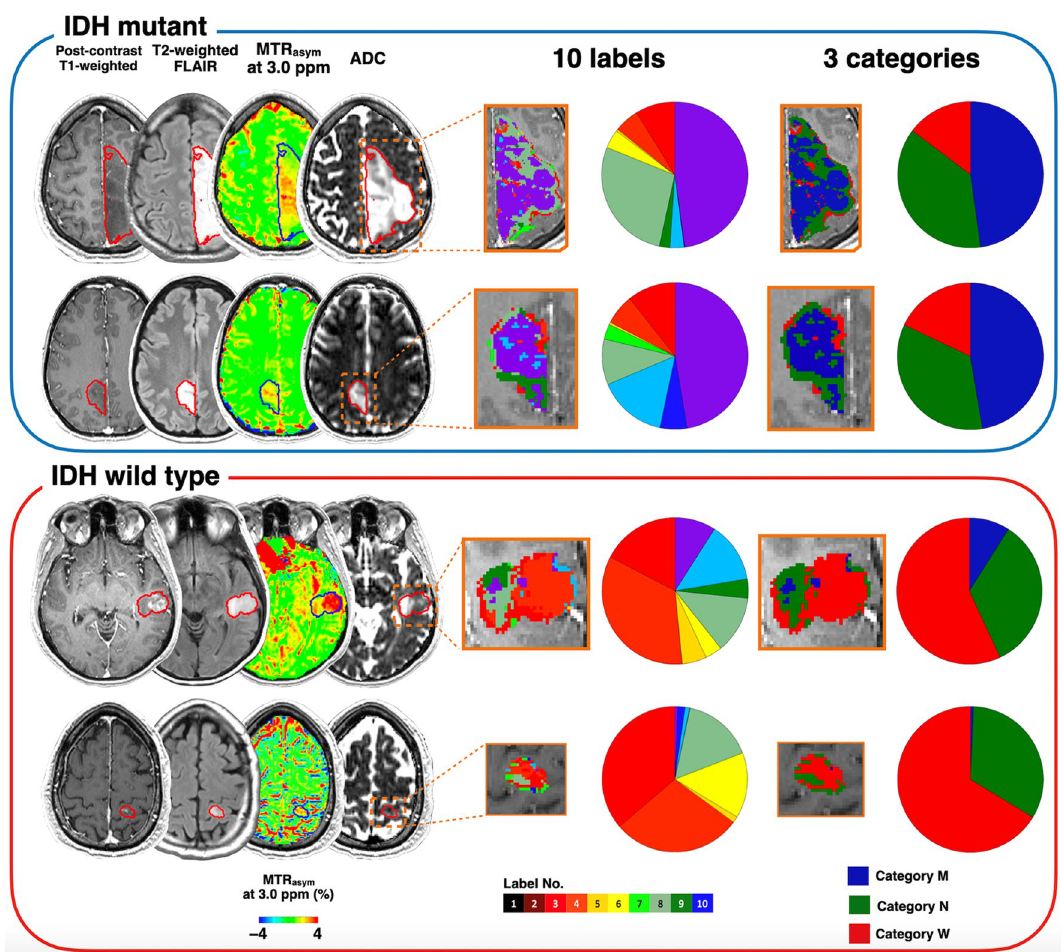
Figure 3. Representative cases of IDH mutant and wild-type gliomas with 10-class clustering. The CE-T1WI and FLAIR images, MTR asym at 3.0 ppm, and ADC maps are shown for each patient. Each color within the tumor ROIs corresponds to each label in the 10-color bar and each category in the 3-color bar. The ratios of each label and category are shown in pie charts. In these examples, labels in category M (label 1) occupied about half of the tumor ROIs in IDH mutant gliomas, while labels in category W (label 7–10) occupied less than a